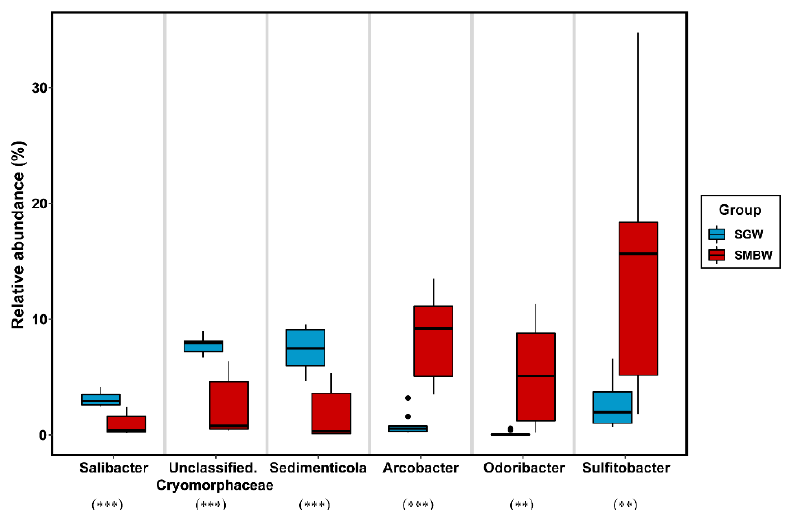
Figure 5. Boxplots to represent indicator species analysis at the genus level in the SGW and SMBW groups. Filled dots represent outliers. The symbols of ** and *** indicate a p value of less than 0.01 and 0.001, respectively.